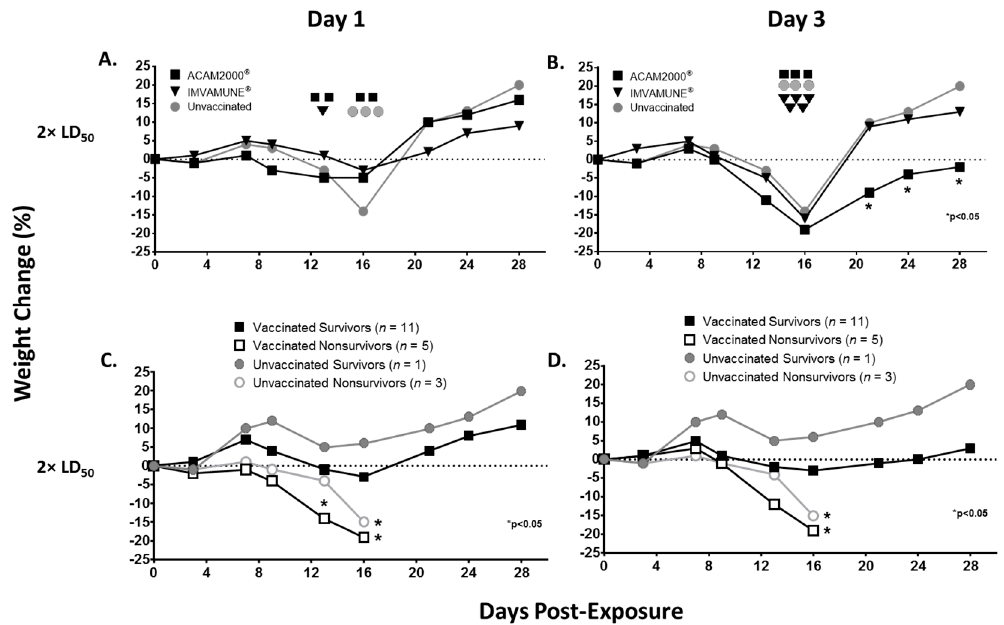
Figure 3. Weight loss. Group median weight changes by percentage at each time-point are shown for animals challenged with 2 × LD 50 dose of monkeypox virus and either unvaccinated (gray circles) or vaccinated 1 day postexposure ( A ) or 3 days postexposure ( B ) with ACAM2000 ® (black squares) or IMVAMUNE ® (black triangles). Euthanized animals for each vaccine group are indicated on the day of euthanasia (same symbols as above). When compared to the unvaccinated animals, only Day 3 ACAM2000 ® -vaccinated animals showed statistically significant differences from Day 21 on by two- way ANOVA ( p < 0.05). Percent weight changes are also shown for vaccinated survivors (filled black squares), vaccinated nonsurvivors (open black squares), unvaccinated survivors (filled gray circles), and unvaccinated nonsurvivors (open gray circles) vaccinated on Day 1 ( C ) or Day 3 ( D ) postexposure. When compared to the unvaccinated survivor controls, Day 1 vaccinated nonsurvivors showed significantly more weight loss on Day 13. On Day 16, both vaccinated and unvaccinated nonsurvivors showed significantly more weight loss regardless of vaccination timing by two-way ANOVA ( p < 0.05). 3.4. Rash Burden In animals challenged with 170× LD 50 MPXV (Figure 4A) or 2× LD 50 MPXV (Figure 4B) there were no significant differences between peak (Day 16) group median lesion counts for ACAM2000 ® - or IMVAMUNE ® -vaccinated animals, regardless of the day of vaccination. This was true for all sampling time-points (data not shown). In the animals challenged with 170× LD 50 MPXV and vaccinated on Day 1 or Day 3, there were no differences between lesion counts in vaccinated and unvaccinated animals (data not shown). However, in the 2× LD50 challenge, all animals vaccinated 1 day postexposure (Figure 4C) manifested fewer secondary lesions than unvaccinated animals, with IMVAMUNE ® -vaccinated animals having significantly fewer at Day 16 by two-way ANOVA ( p < 0.05). For animals vaccinated on Day 3 postexposure (Figure 4D), ACAM2000 ® -vaccinated—but not IMVAMUNE ® -vaccinated—animals’ lesion counts were lower than unvaccinated animals at all time- points, but this difference did not reach statistical significance by two-way ANOVA ( p < 0.05).